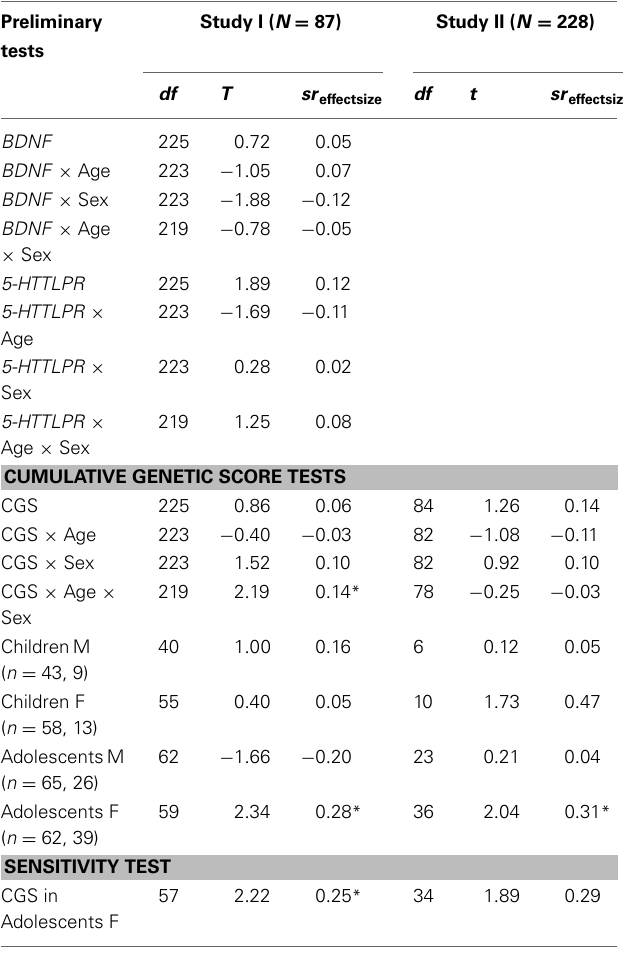
Table 3 | Genetic associations with co-rumination: multiple linear regressions test whether the CGS directly or in moderation with age or gender, predicts youths’ tendency to